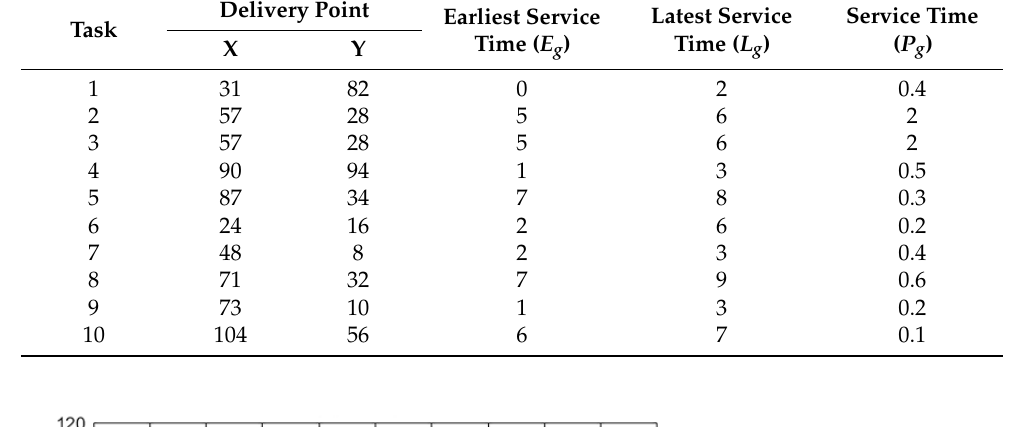
Table 2. Optimal schedule of SR.